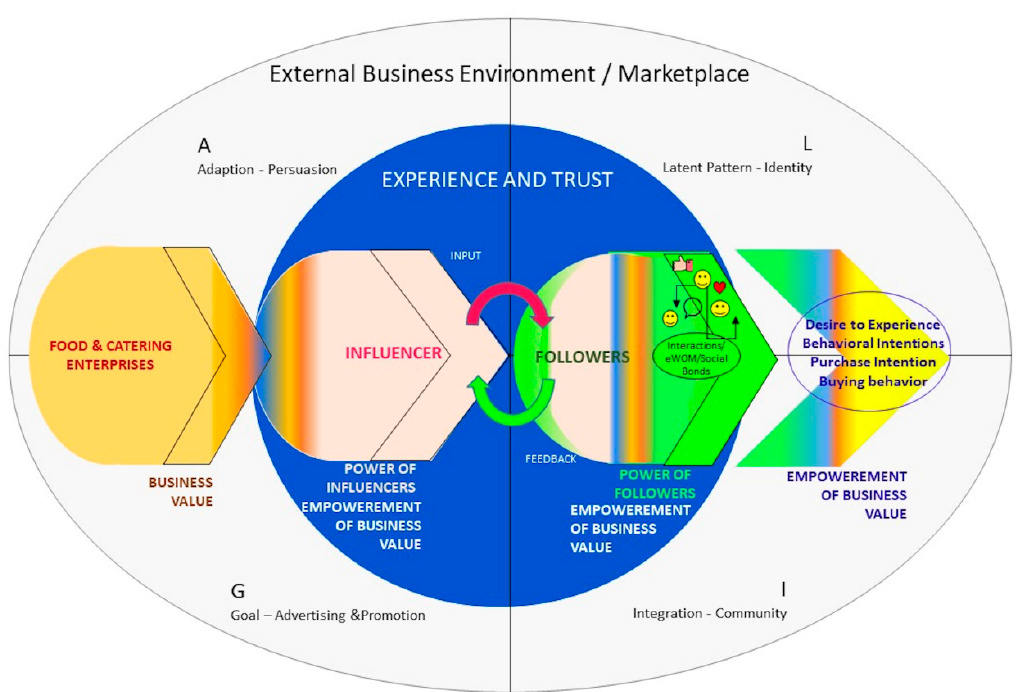
Figure 3. Graphical representation of the new model of open innovation for food and catering businesses promotion and advertising. AGIL are the communication dimensions analyzed. Food and catering enterprises, influencers, and followers are displayed in the plain based on their communication type. Experience and trust involve both influencers and followers about local food and restaurants. Outside the experience context, there are other people in social media that are persuaded to experience the product/service by the influencer’s followers through interactions, eWoM, and social bonds.